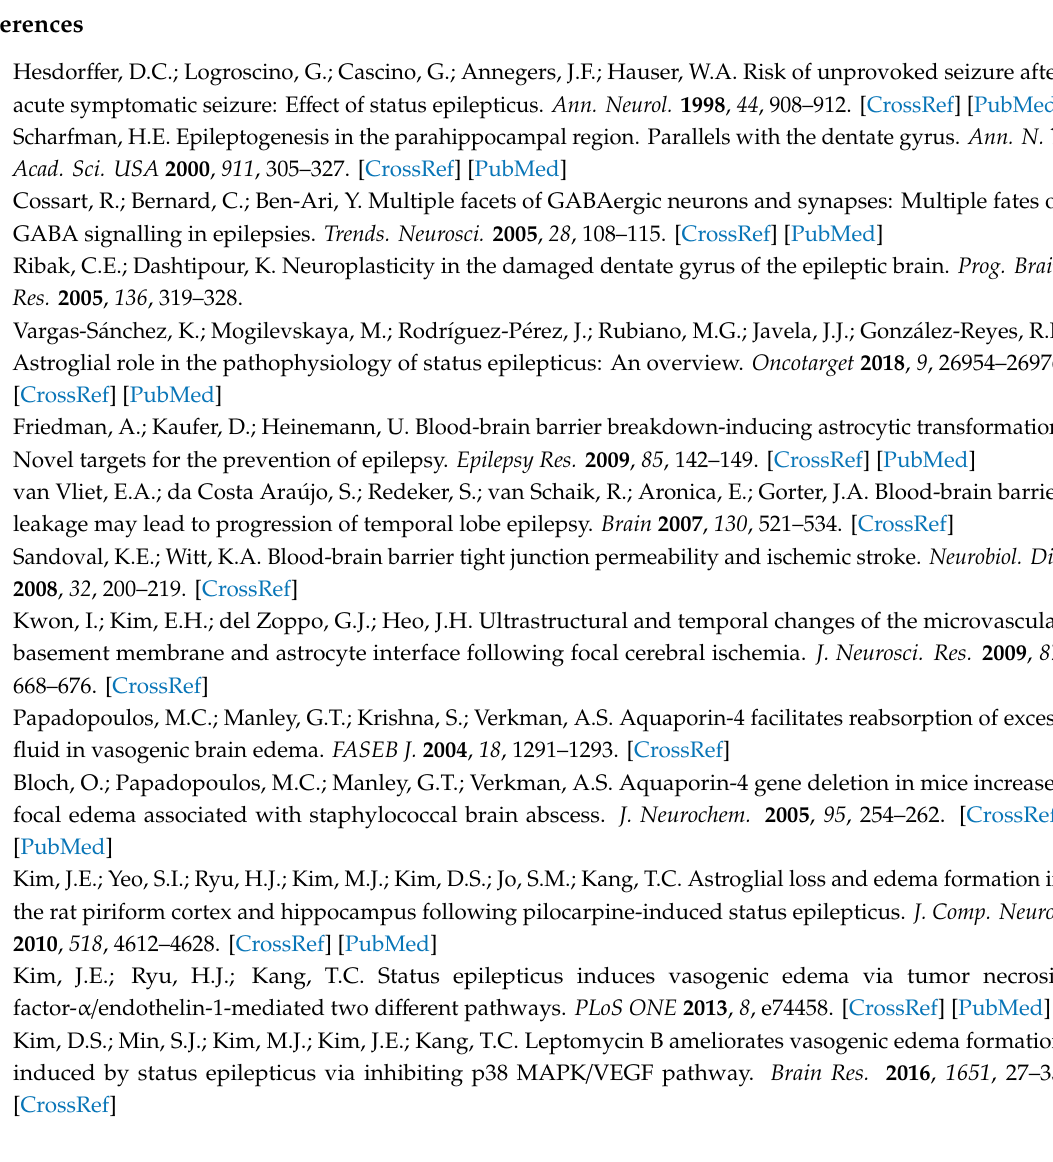
Figure S1: Representative full-gel images of Western blots in Figure 2, Figure S2: Representative full-gel images of Western blots in Figure